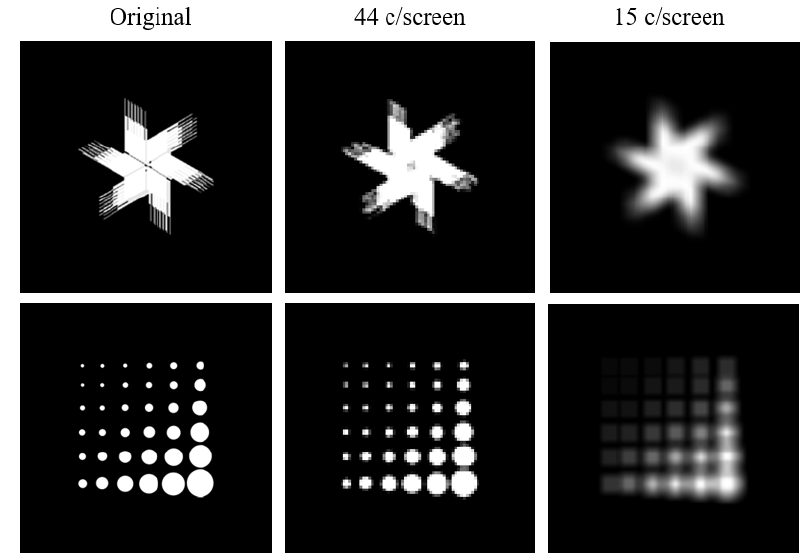
Figure 6. Commonly used training stimuli for the touchscreen setup, edited to reflect the limits of rat vision as defined by our acuity experiments. Pixel size is adjusted to reflect how the animals would perceive the images assuming a specific